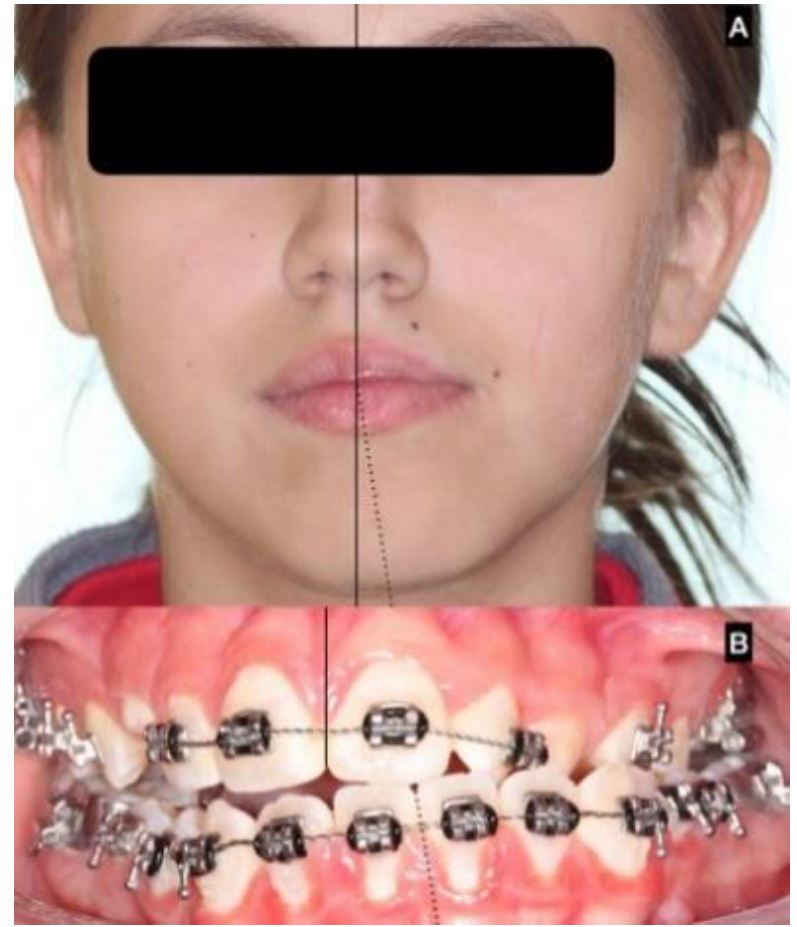
Figure 1. Clinical presentation of unilateral condylar hyperplasia and facial asymmetry. ( A ) chin deviation with a class III trend; ( B ) lack in dental midline and unilateral crossbite dental occlusion. In terms of clinical classification, UCH was first proposed by Obwegesser and Makek [6] and later by Wolford et al. [7], showing characteristics of the disease as a type of deformity, age and clinical considerations about treatment (Figures 2 and